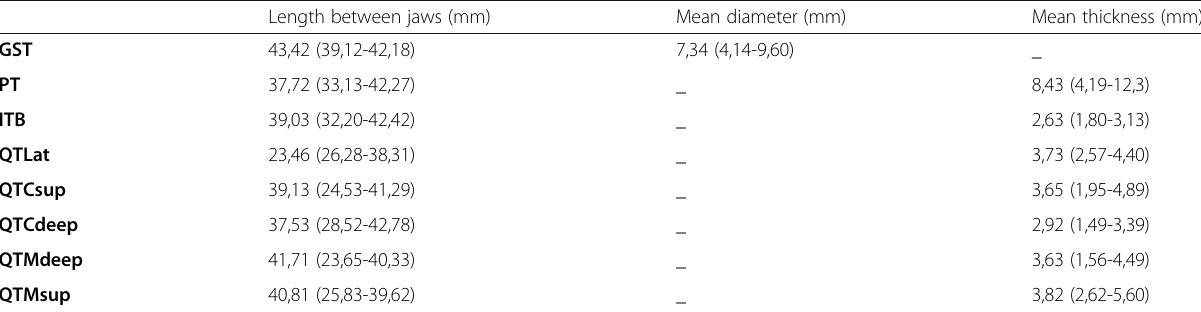
Table 1 Physical characteristic of the